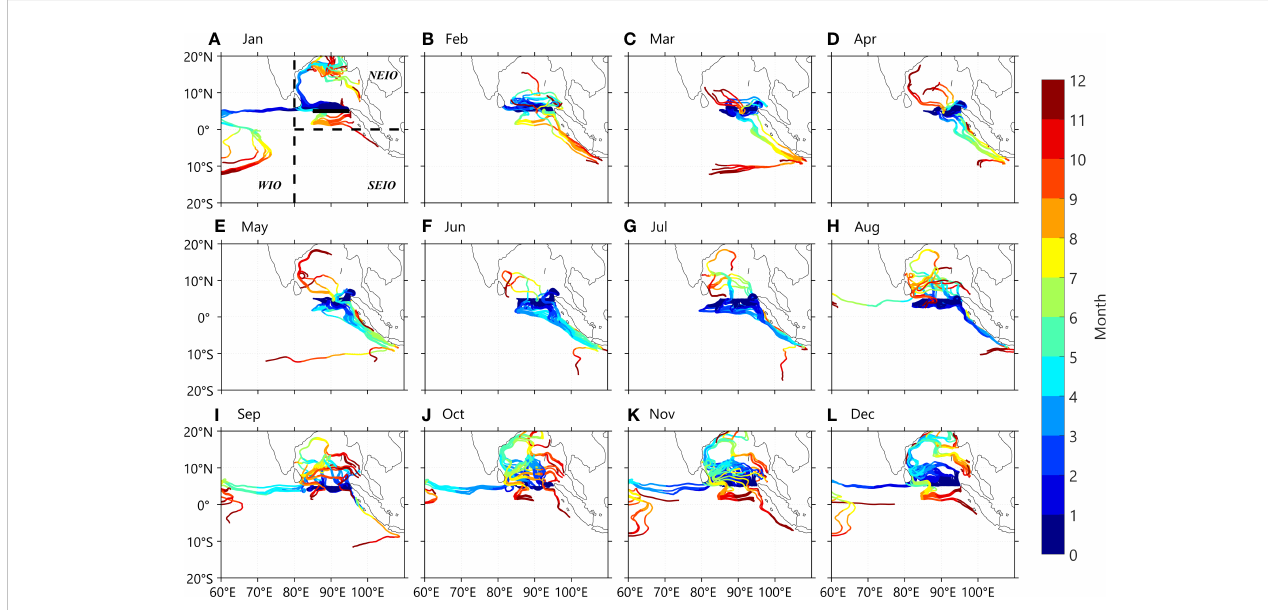
FIGURE 4 Same as Figure 3, but tracked using the drifter-derived currents